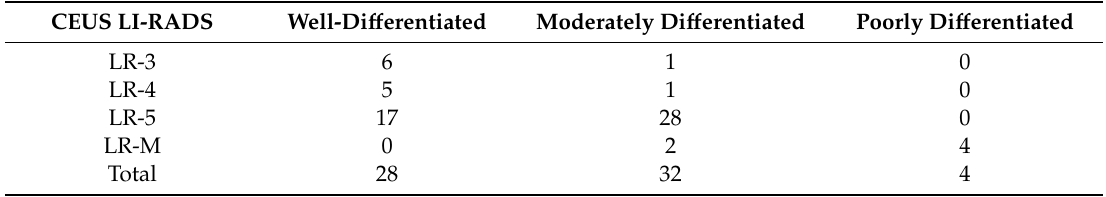
Table 7. Relationship between modified CEUS LI-RADS classification and HCC histologic differentiation. CEUS